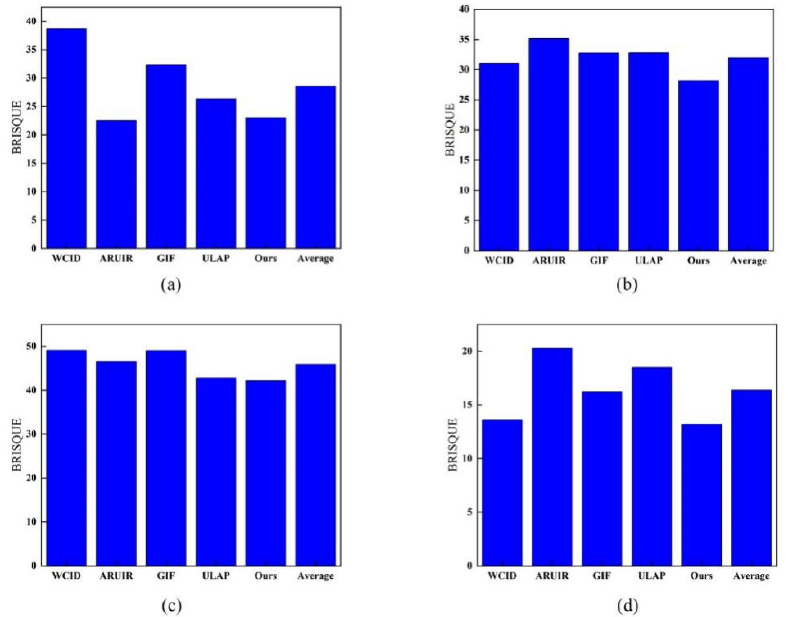
Figure 10. ( a ) Figure 5a uses the BRISQUE values of different algorithms, ( b ) Figure 6a uses the BRISQUE values of different algorithms, ( c ) Figure 7a uses the BRISQUE values of different algorithms and ( d ) Figure 8a uses the BRISQUE values of different algorithms.